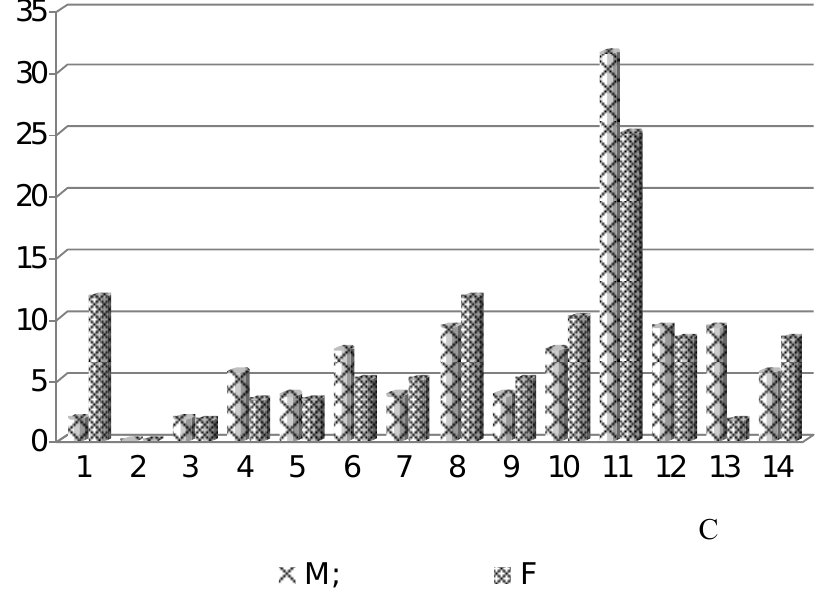
Fig. 3. Structure of incidence of the studied contingent: N – number of students, %; C – class of disease; M –